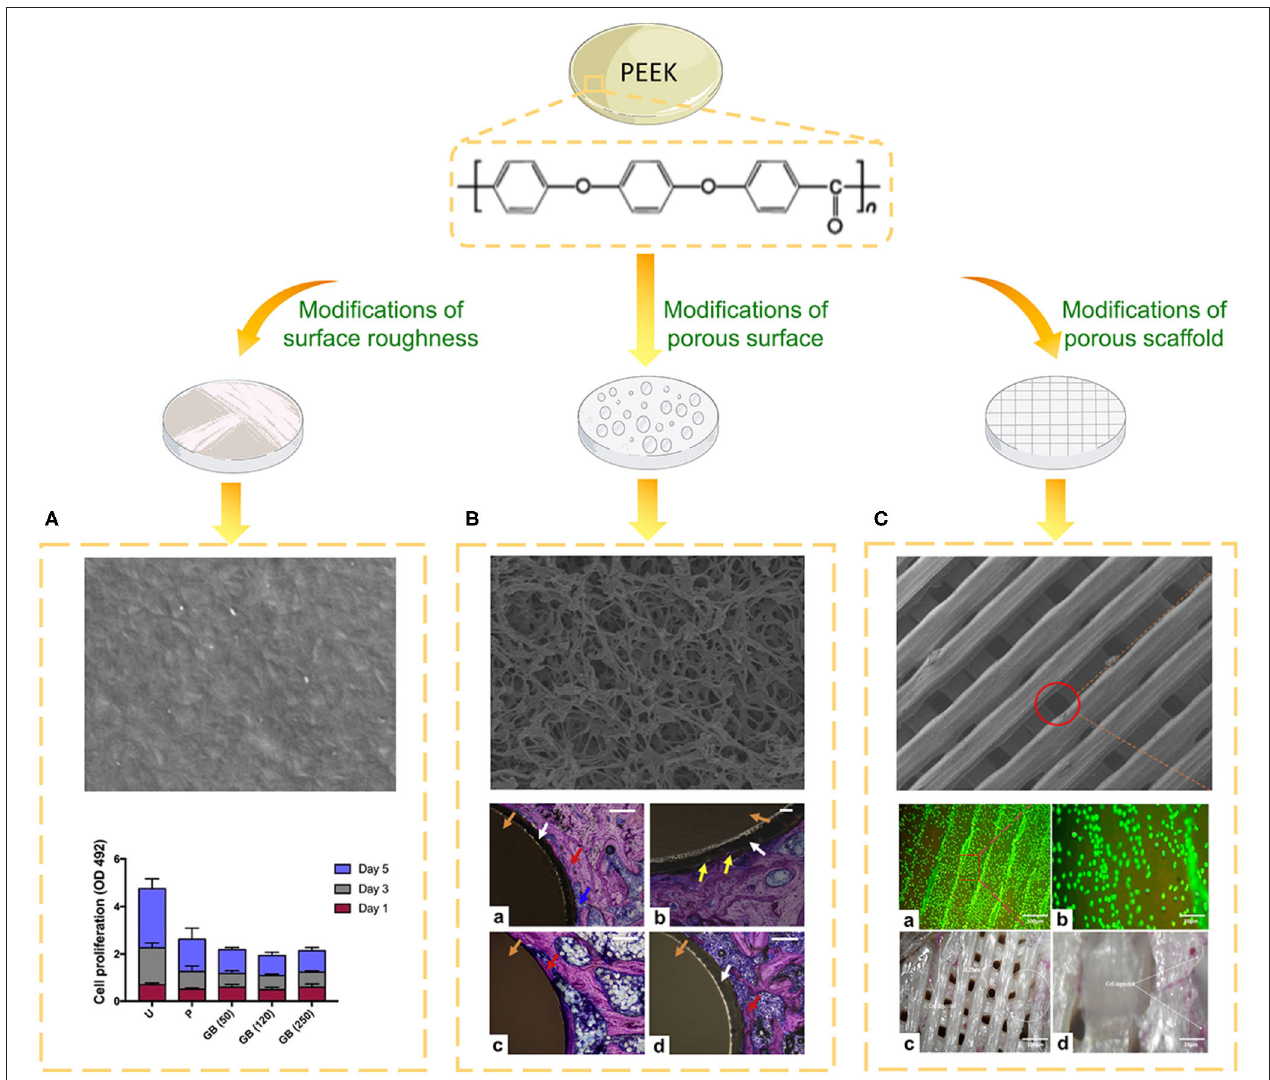
FIGURE 3 | Biological evaluation of PEEK implants with different topographies. (A) SEM image of the surface of PEEK formed via fused filament fabrication and the cell proliferation of different groups on days one, three, and five. U, untreated; P, polished, GB (50), 50 µ m grit-blasted; GB (120), 120 µ m grit-blasted; and GB (250), 250 µ m grit-blasted (Han et al., 2019a). (B) SEM image of the surface of sPEEK-WA and Giemsa-stained hard tissue around the implant at 8 weeks after implantation. Red arrows represent the newly formed bone, yellow arrows represent bone ingrowth, blue arrows represent osteoblasts, white arrows represent the sPEEK layer, and orange arrows represent the PEEK implant. (a) PEEK, (b) sPEEK-W, (c) sPEEK-A (low magnification), and (d) sPEEK-WA (high magnification). Scale bar is 200 µ m. Reproduced from Zhao et al. (2013). Copyright (2013), with permission from Elsevier. (C) SEM image, cell spreading (a,b) and ALP activity (c,d) of the PEEK/cHAp scaffold after cultivation for 14 days: (a) magnification of 300 µ m, (b) magnification of 50 µ m, (c) magnification of 100 µ m, and (d) magnification of 20 µ m. Reproduced from Oladapo et al. (2020). Copyright (2020), with permission from